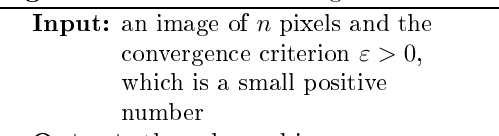
Algorithm 3: The 2-ACCE